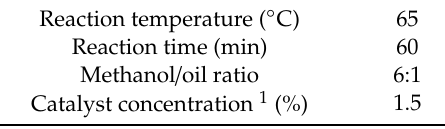
Table 1. Transesterification reaction conditions for obtaining sa ffl ower